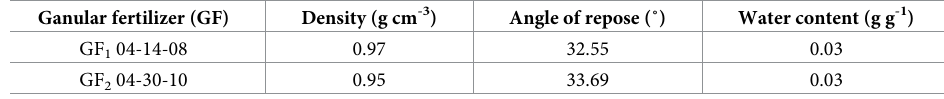
Table 2. Density, angle of repose, and water content of granular fertilizers.